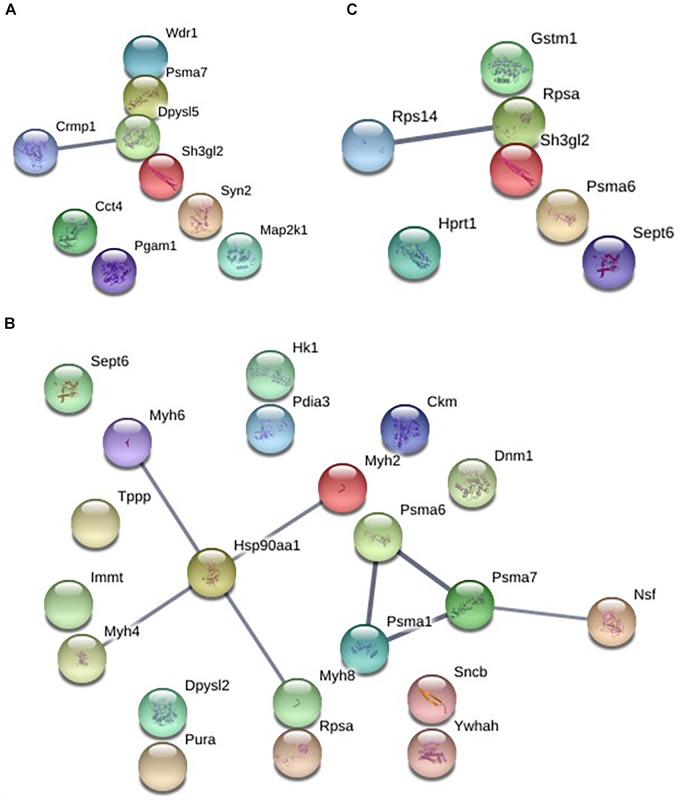
Graphic representation of the protein–protein interaction networks with significant differences between the groups in dorsal hippocampal formation. EGb 0.25 g⋅kg−1 (nine nodes), enrichment P-value = 0.127 (A). EGb 0.50 g⋅kg−1 (21 proteins), enrichment P-value = 0.000335 (B). EGb 1.00 g⋅kg−1 (seven proteins), enrichment P-value = 0.592 (C).